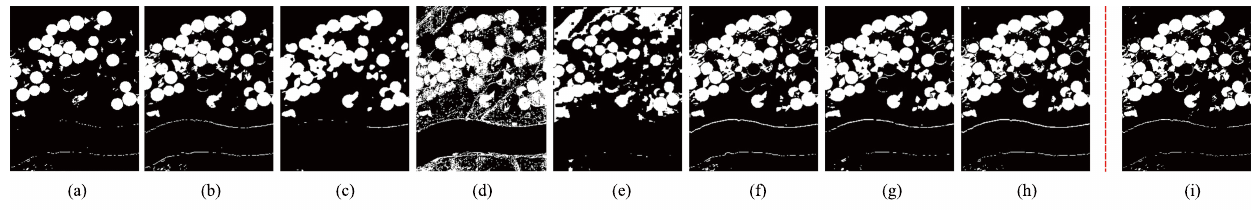
Figure 10. The change map results of different methods on the Irrigated Agriculture Dataset. ( a ) CVA. ( b ) SVM. ( c ) GETNET. ( d ) DSFANet. ( e ) WCRN. ( f ) Without FRL. ( g ) Without PS 2 A. ( h ) TFR-PS 2 ANet. ( i ) Ground